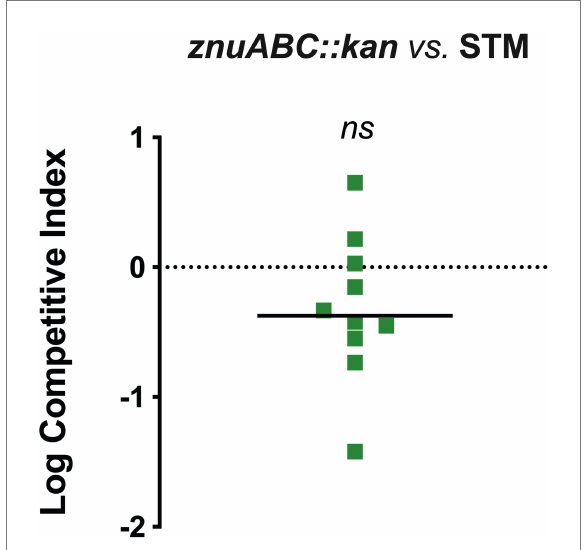
FIGURE 3 Competition assay in Col-0 between znuABC::kan and STM. The seedlings were inoculated with a mixed inoculum of znuABC::kan (strain A) and STM (strain B), in a 1:1 ratio. At 3 dpi, the ratio of the two strains was enumerated in shoots homogenates and the competitive index was calculated as described in the section Materials and methods. Statistical significance was obtained by the Student’s t -test ( ns , not significant). A horizontal straight line indicates the median CI value. The graph is representative of two independent